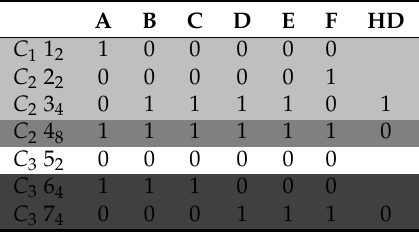
Table 5. Example of a first assignment in the grid for the Figure 3 DAG task using the DAG task